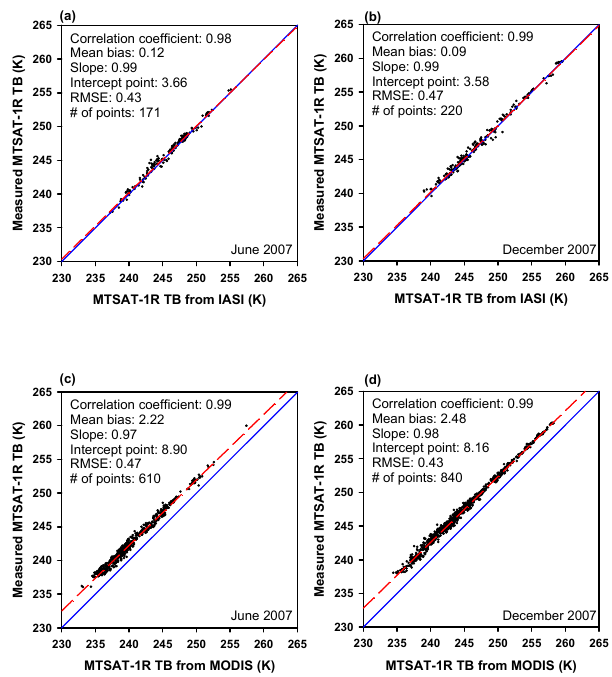
Figure 3: Scatter plots of IASI equivalent MTSAT-1R and measured MTSAT-1R water vapor Fig. 3. Scatter plots of IASI equivalent MTSAT-1R and mea- channel brightness temperatures for June 2007 (a) and December 2007 (b), and of MODIS sured MTSAT-1R water vapor channel brightness temperatures for equivalent MTSAT-1R and measured MTSAT-1R water vapor channel brightness temperatures for June 2007 (c) and December 2007 (d). June 2007 (a) and December 2007 (b) , and of MODIS equivalent MTSAT-1R and measured MTSAT-1R water vapor channel bright- ness temperatures for June 2007 (c) and December 2007 (d) .